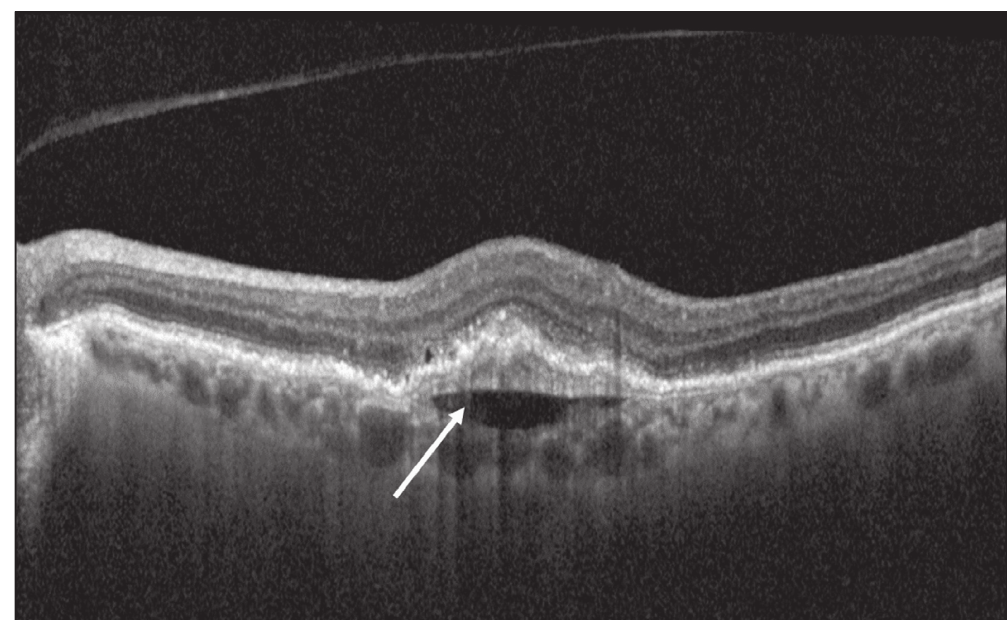
Figure 8: Structural biomarker: prechoroidal clefts (white